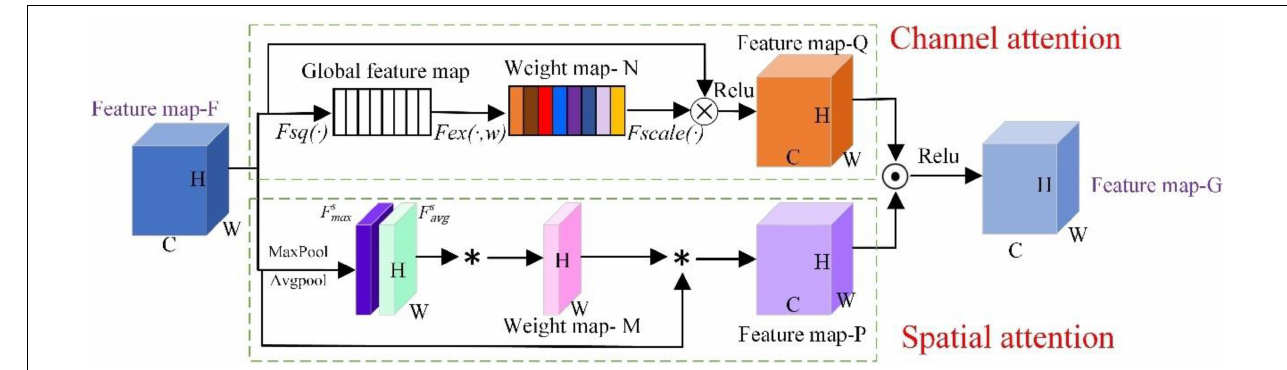
FIGURE 3 | The structure of the parallel attention